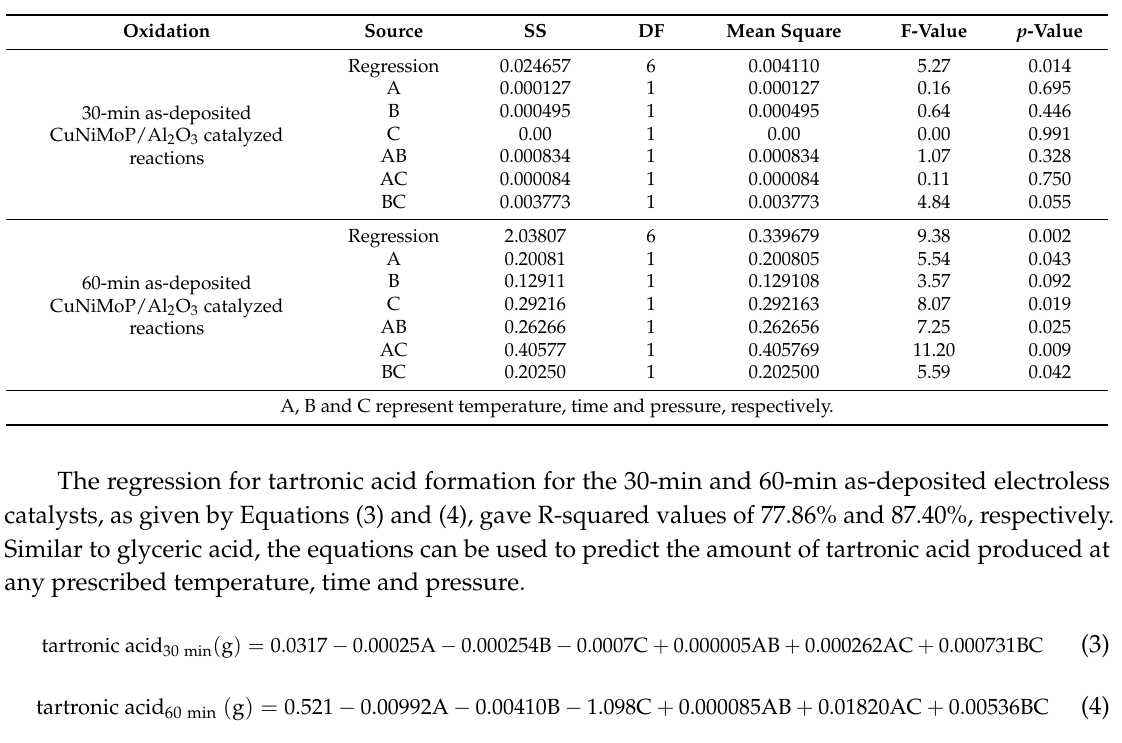
Table 8. ANOVA results for tartronic acid